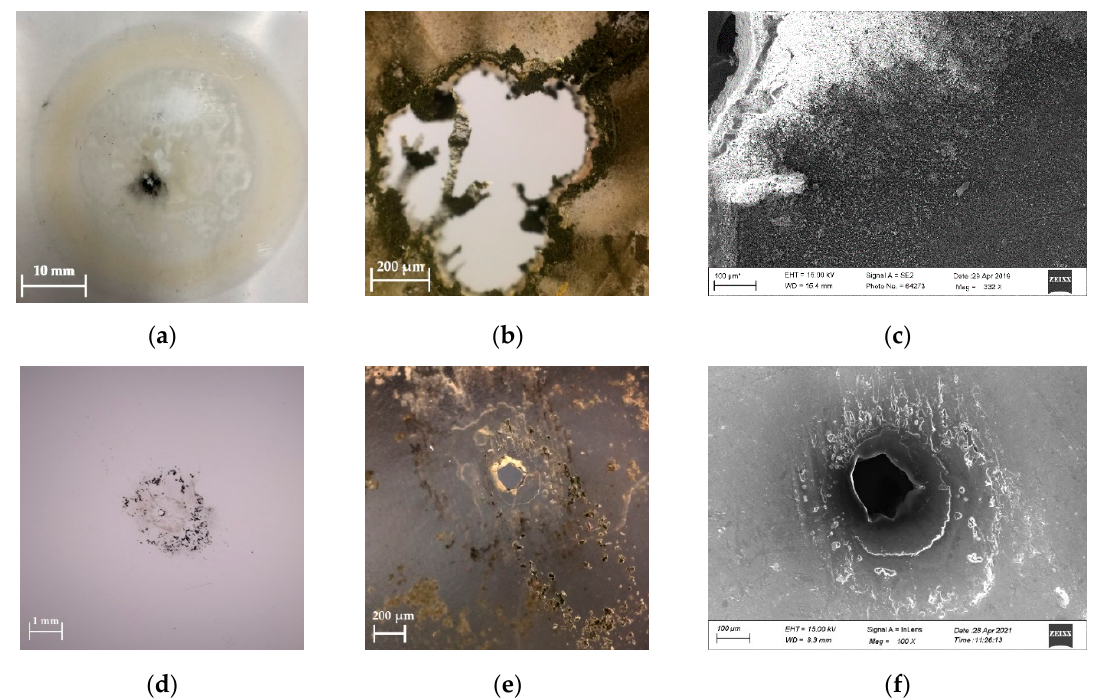
Figure 5. The surface morphology of the breakdown-point for samples after being tested under DC and AC electric field. ( a ) Ordinary photo obtained by digital camera of samples after being tested under AC electric field [21]; ( b ) magnification photo obtained by optical microscope of samples after being tested under AC electric field [21]; ( c ) SEM image of samples after being tested under AC electric field; ( d ) ordinary photo obtained by digital camera of samples after being tested under DC electric field; ( e ) magnification photo obtained by optical microscope of samples after being tested under DC electric field; ( f ) SEM image of samples after being tested under DC electric